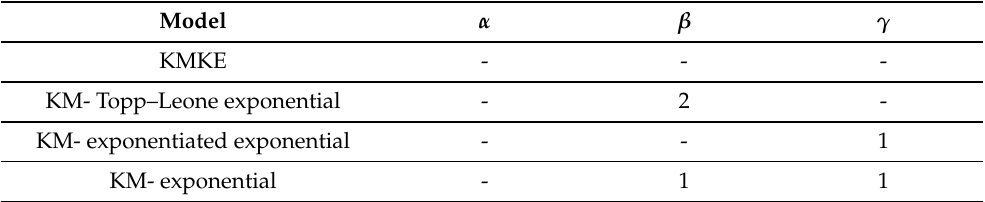
Table 2. Some sub-models of the KMKE model.